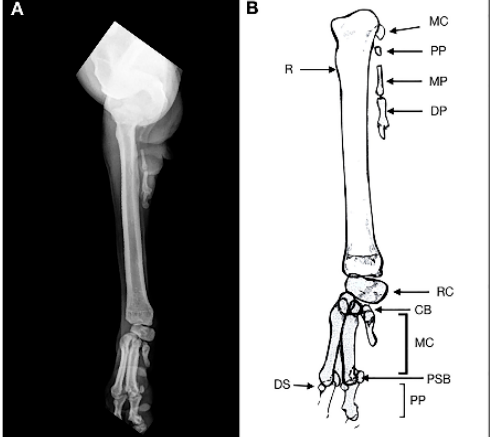
Figure 2. Case 1. Craniocaudal radiograph ( A ) and drawing scheme ( B ) of the right forelimb mal-